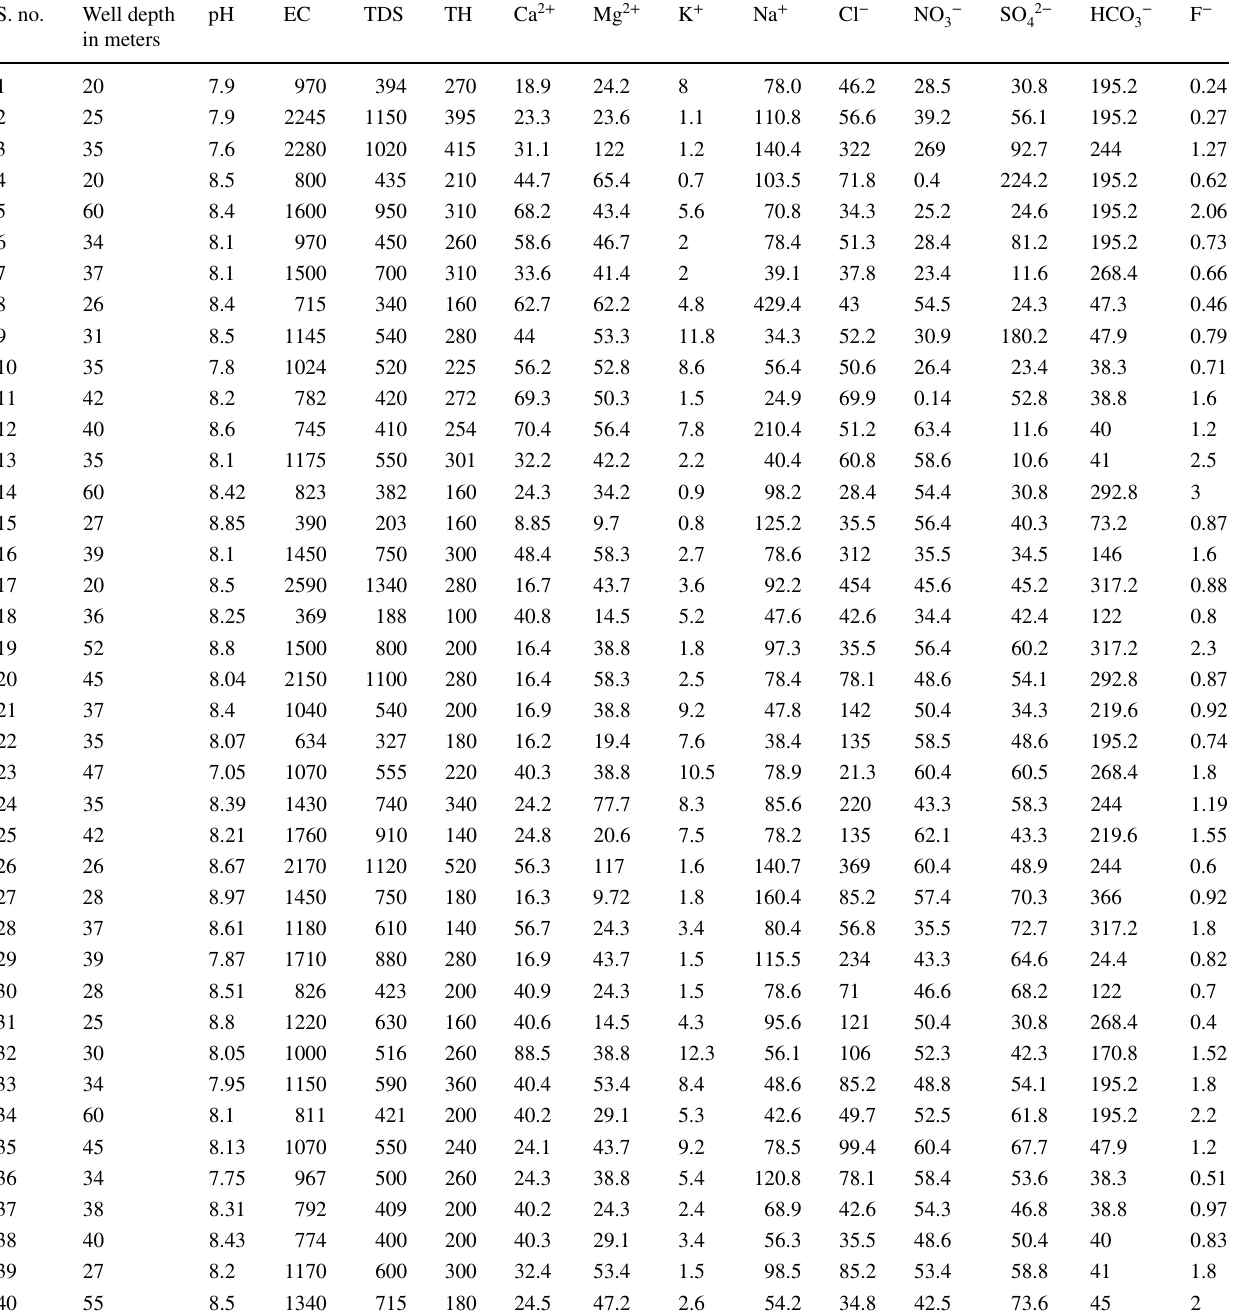
Table 3 Physicochemical parameters concentrations of the study area